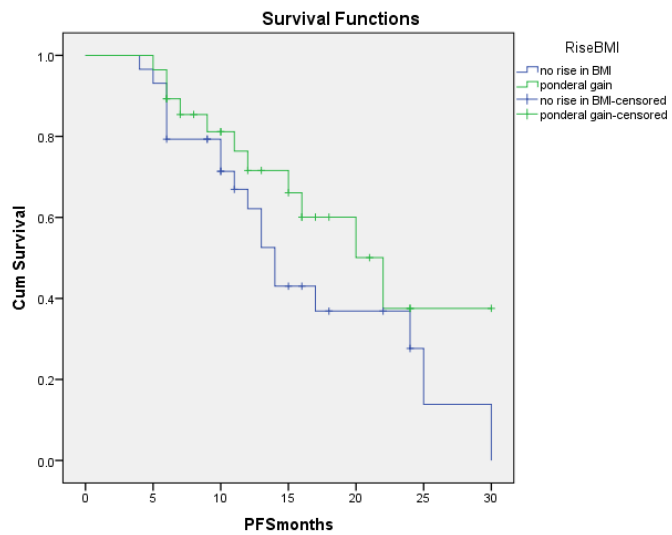
Figure 2. PFS for patients who had weight gain vs. patients who did not after three months of nivolumab treatment.